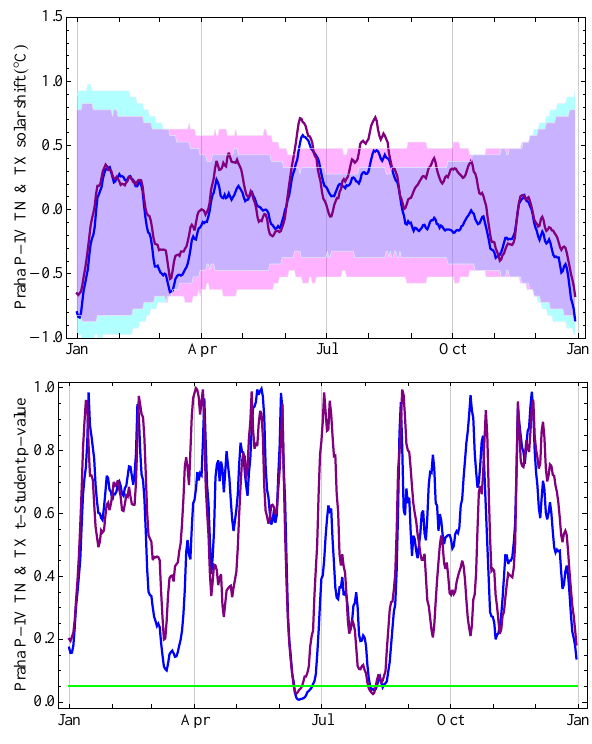
Fig. 6. Upper panel: solar shift for TN (blue) and TX (purple) temperatures in Praha after removal of the 5 last solar cycles. Cyan area: 90% confidence interval for TN solar shift. Red area: 90% confidence interval for TX solar shift. Colors combine into violet upon superposition. Lower panel: p-value of the Student t-test for the TN (blue) and TX (purple) solar shifts. The green line marks the 5% level.